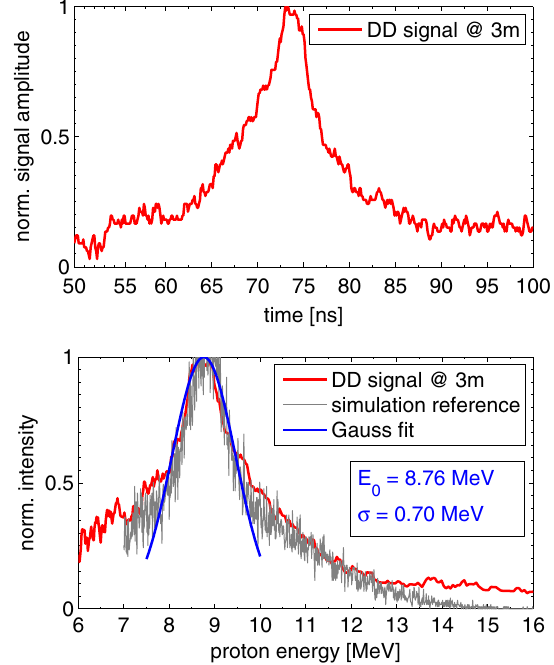
FIG. 2. ToF results from the diamond detector (upper picture) and obtained proton spectrum (lower picture) for the case of focusing 8.8 MeV protons at 3 m, for which the FWHM is 8.6 ns (ToF) or 1.6 MeV (energy spectrum). A Gaussian with a σ ¼ 0 . 70 MeV fits the central part of the bunch well. Also indicated is the particle spectrum used in the comparative